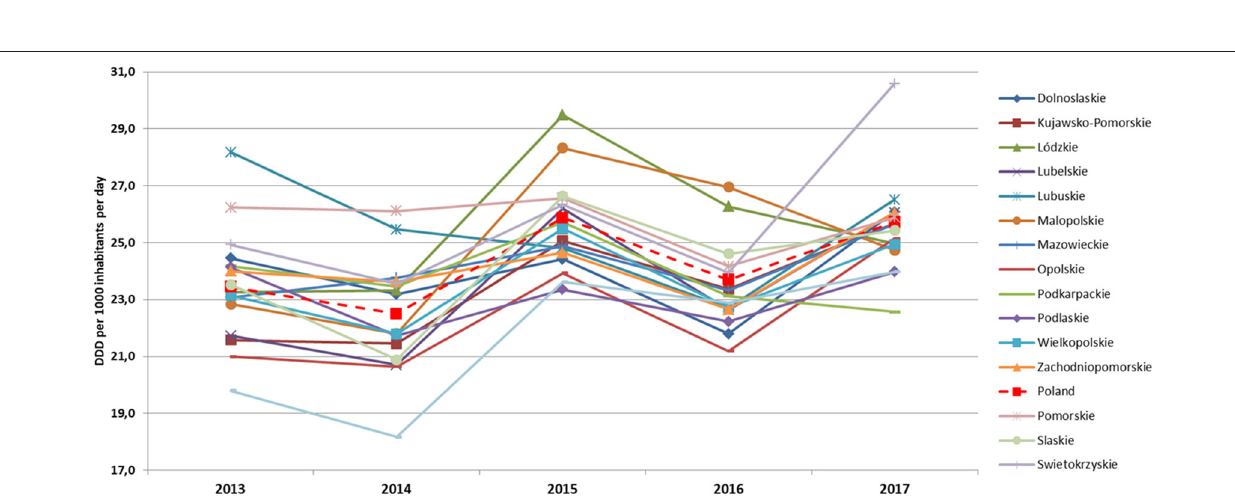
FIGURE 2 | Antimicrobial consumption trends in the period 2013–2017 in primary care in Polish voivodships (DDD and